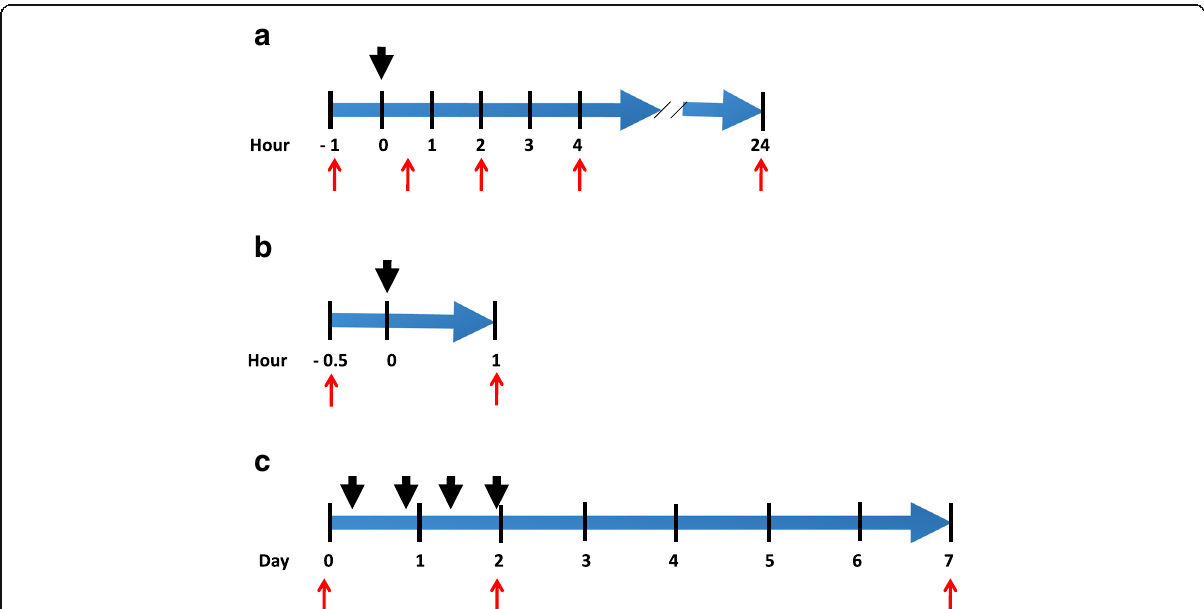
Fig. 2 Timeline of investigational studies. ( a ) Study design for healthy subjects at AMC; ( b ) Study design for healthy subjects at FIMR; ( c ) Study design for RA patients at FIMR. Black arrows indicate application of vibrotactile treatment. Red arrows indicate time of blood draws for healthy subjects ( a , b ) and clinical assessments for RA patients ( c